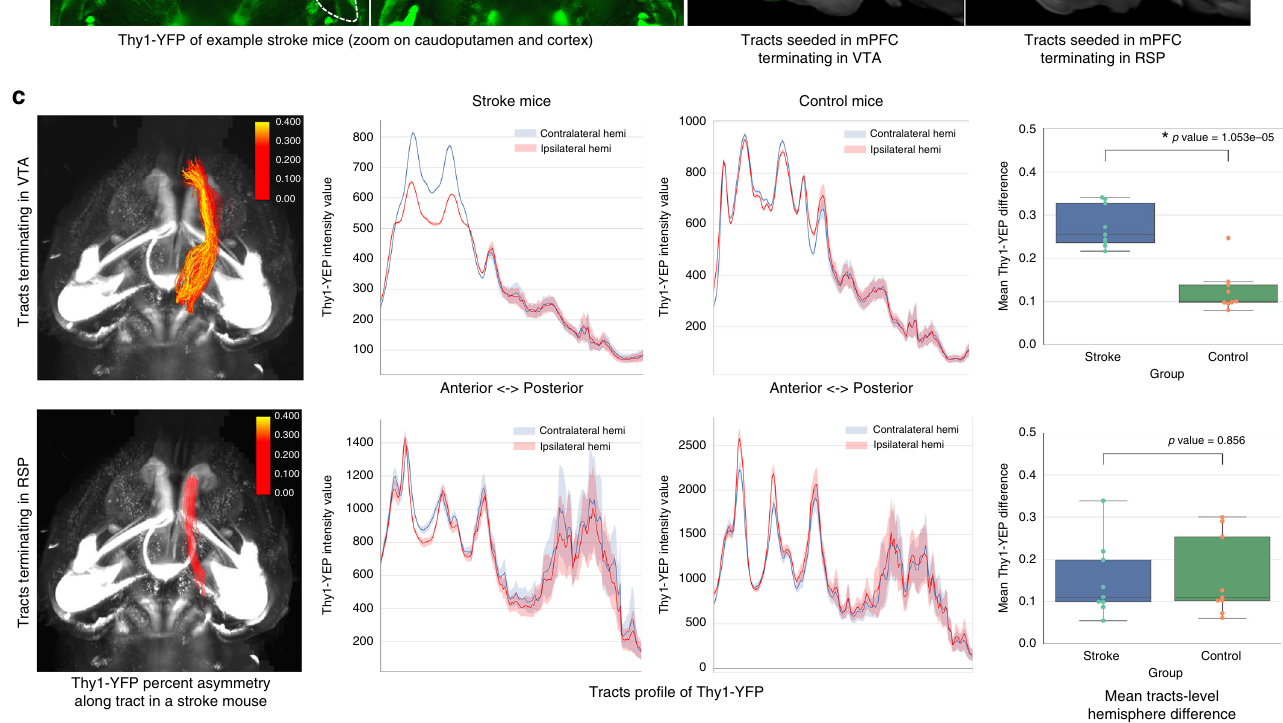
Fig. 8 Thy1-YFP cellular modulations along dMRI-based tractography in acute stroke. a Thy1-YFP CLARITY axial images from a stroke mouse showing lower staining on the right hemisphere (right caudoputamen outlined). Images were intensity corrected for this fi gure (not for the analysis) to account for signal drop at the base of the olfactory bulb. b Two tracts were identi fi ed by probabilistic CSD tractography on our ultra-high resolution ex vivo dMRI dataset, seeding (starting from) the mPFC and targeting either VTA or RSP. Tracts were fi ltered to include only terminating fi bers. c Cellular modulation along ipsilateral VTA but not RSP tracts in stroke mice compared to controls. Left: Track-based Thy1-YFP asymmetry depicted along these two tracts. Color scale represents percentage of asymmetry. Center: Tract-based Thy1-YFP intensity for the two tracts ipsilateral (red) and contralateral (blue) to the stroke, showing a decrease along the tract targeting the VTA but not the RSP. Right: Mean tract-level difference between contralateral and ipsilateral Thy1-YFP intensity, divided by the mean of contralateral Thy1-YFP intensity. x -axis of the graphs represents nodes (locations) along tracts going anterior (left) to posterior (right). Center line of box plot represents the median, bounds represent the fi rst and third quantiles, and whiskers represent the lowest and highest datum within 1.5× the interquartile range of the lower and upper